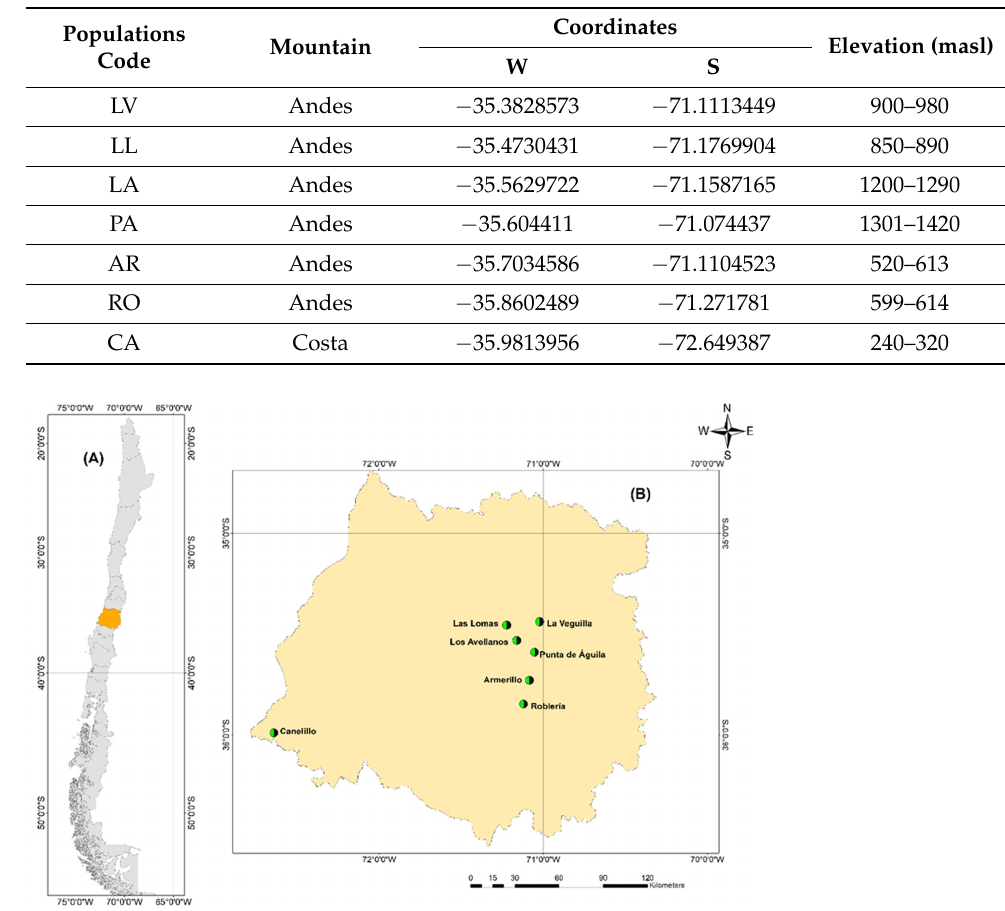
Table 1. Plants material collected sites of the seven populations of G. avellana Mol. used in the study. Location distributed from north to south: La Veguilla (LV), Las Lomas (LL), Los Avellanos (LA), Punta de Á guila (PA), Armerillo (AR), Robler í a (RO), and Canelillo (CA).